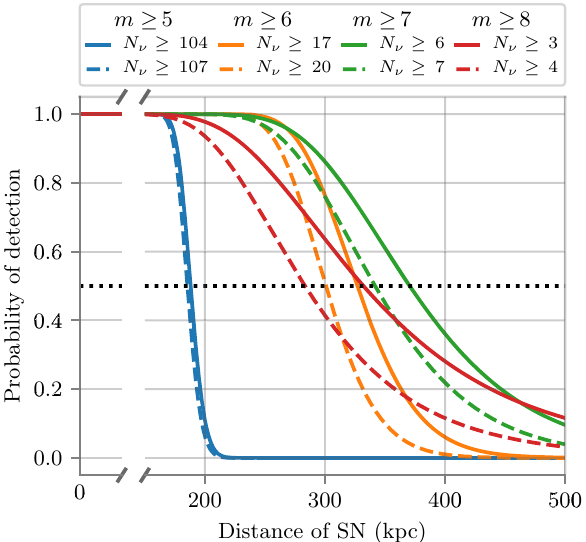
Fig. 8 Probability for the detection of a CCSN of 27M (cid:2) progenitor mass as a function of distance using the trigger conditions presented in